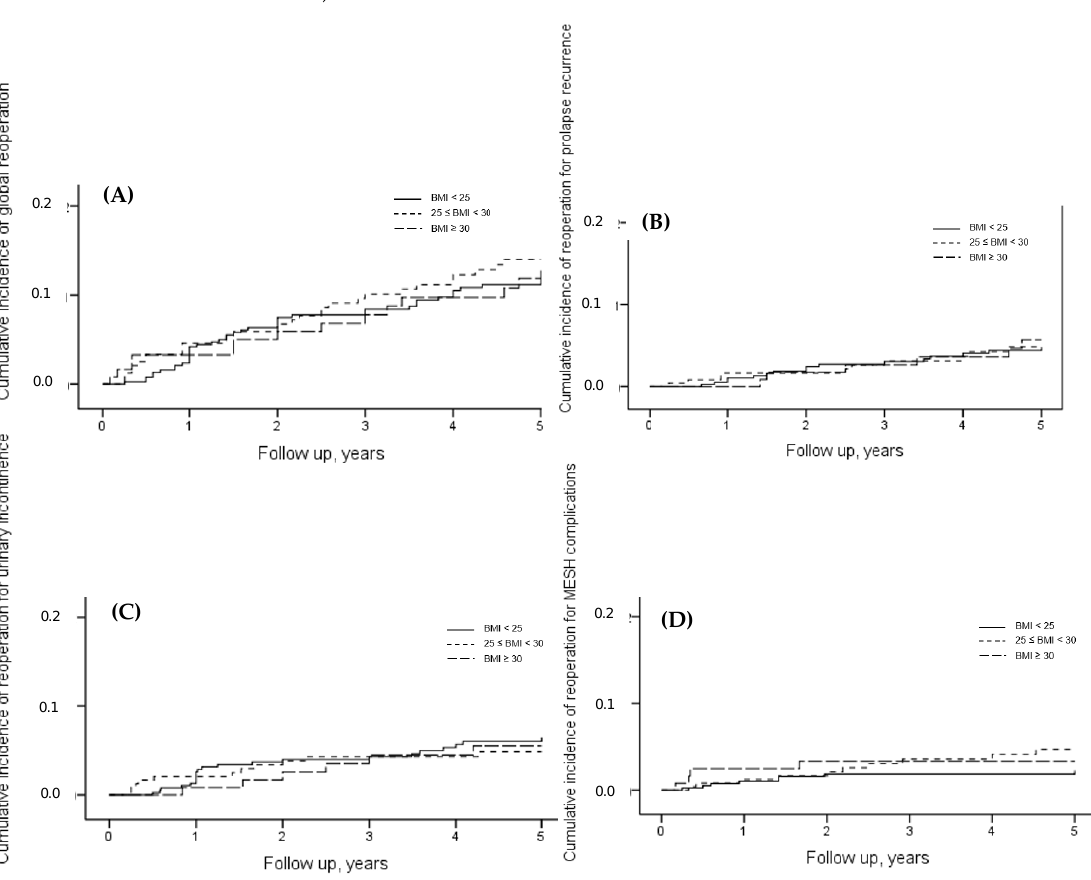
Figure 2. Cumulative incidence over 5 years of global reoperation, reoperation for prolapse recurrence, urinary incontinence, and mesh-related complications. ( A ) Cumulative incidence over 5 years of global reoperation. ( B ) Cumulative incidence over 5 years of prolapse recurrence. ( C ) Cumulative incidence over 5 years of reoperation for urinary incontinence. ( D ) Cumulative incidence over 5 years of reoperation for mesh-related complications. BMI: body mass index (kg/m 2 ). Table 2. Comparisons between the three BMI groups according to the initial surgical approach